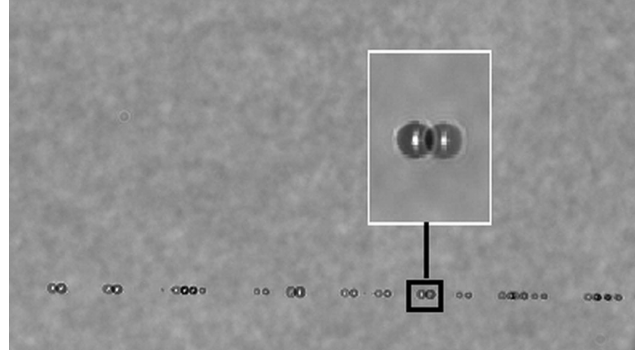
Figure 9 Double exposure stroboscopic imaging of droplets with two nanosecond lasers with a delay of hundreds of nanoseconds between the two pulses. A zoomed view of one of the droplets imaged is shown in the inset. The image was collected using the side microscope with a 10 (cid:3) objective and an Andor Zyla 5.5 camera.